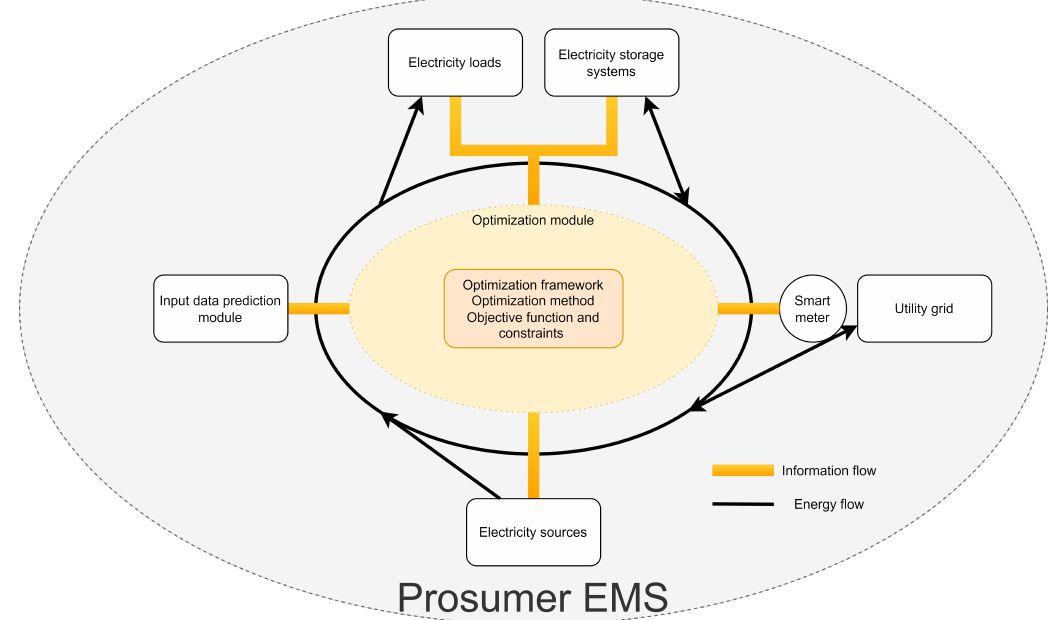
Figure 3. Overview of the prosumer